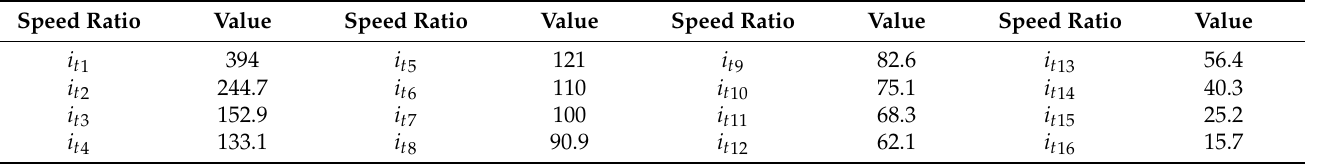
Table 2. Optimized speed ratio data.